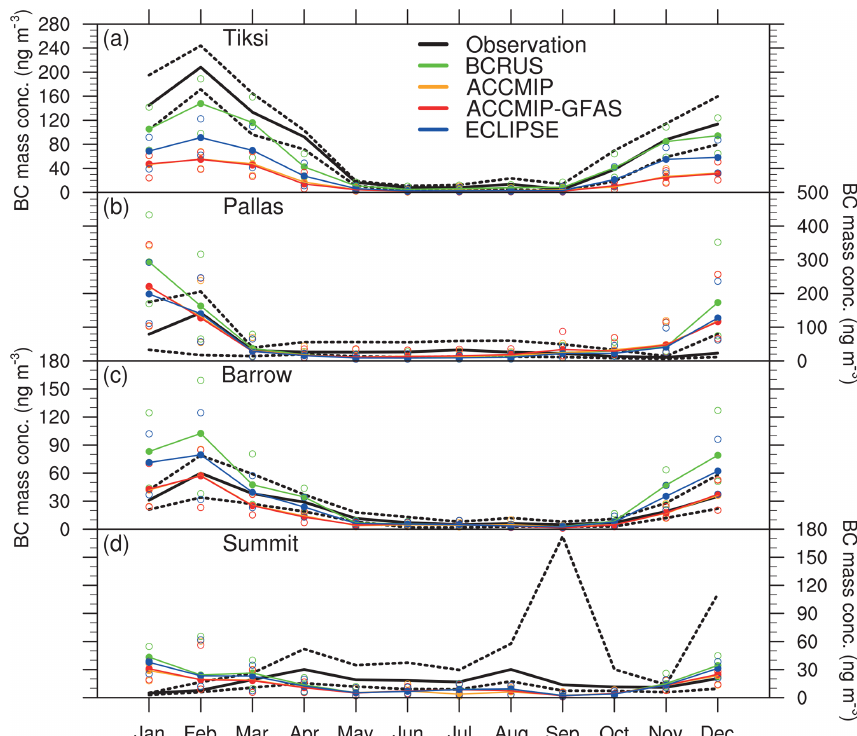
Figure 7. As in Fig. 6 for the stations in (a) Tiksi, (b) Pallas, (c) Barrow and (d)